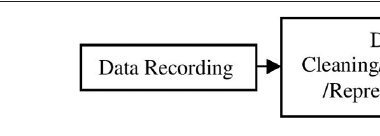
FIGURE 4 | Data preprocessing technique.